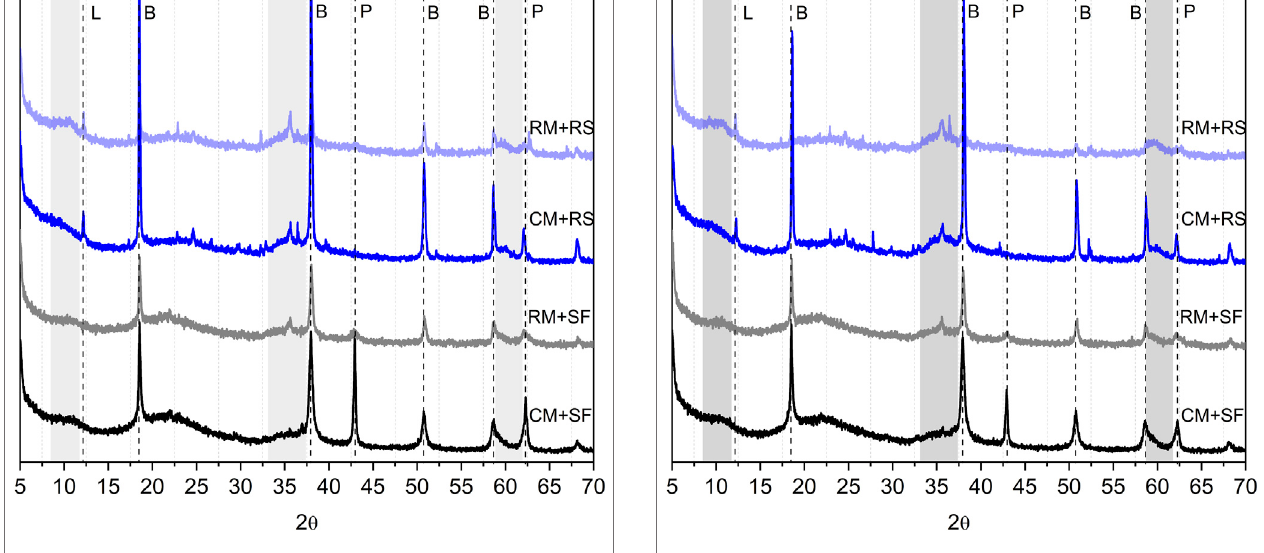
FIGURE 4 | XRD patterns of 28 days hydrated samples (P: Periclase, B: Brucite, L: Lizardite, grey bands correspond to